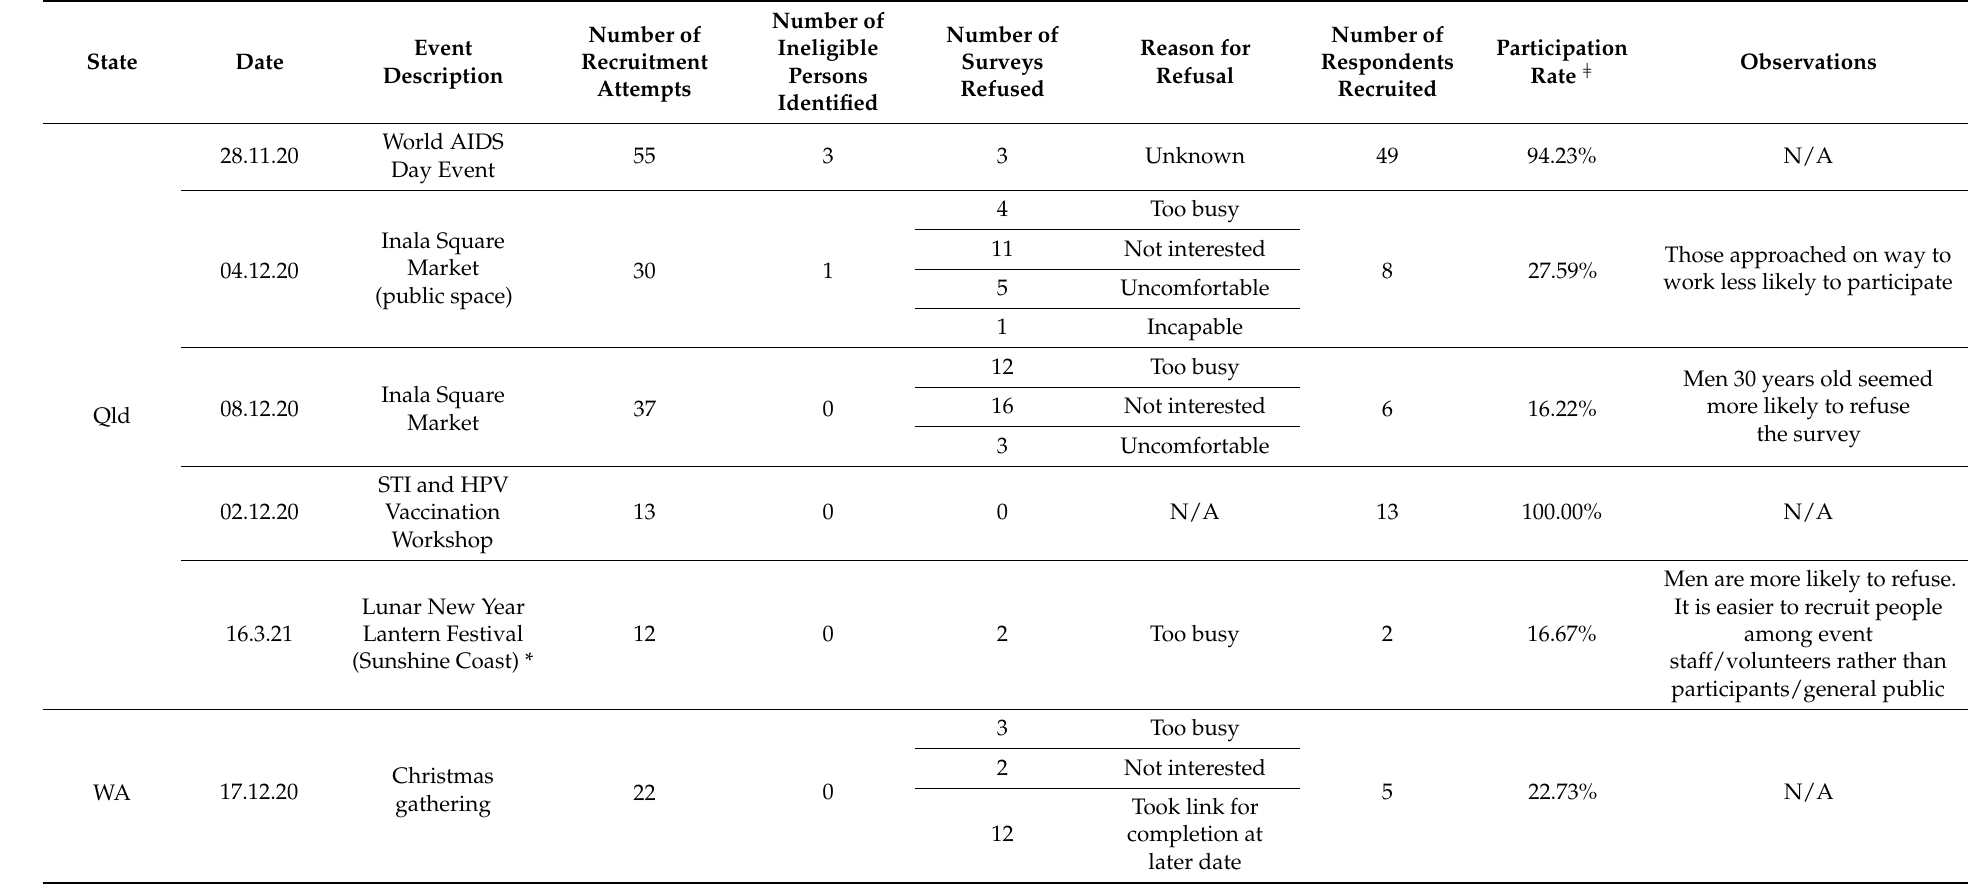
Table 6. Outcomes of recruitment to paper surveys at public venues/events by date and